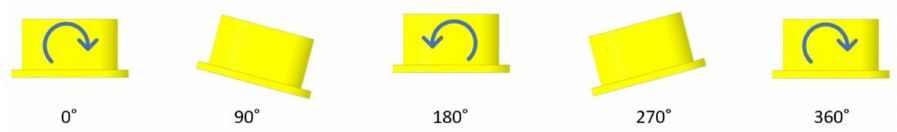
Figure 12. Schematic of pitch phase angles and respective rotation.